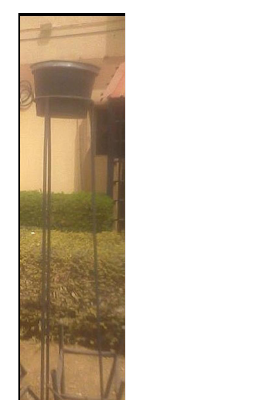
Fig. 2. A modified Tauber sampler mounted at one of the two study sites